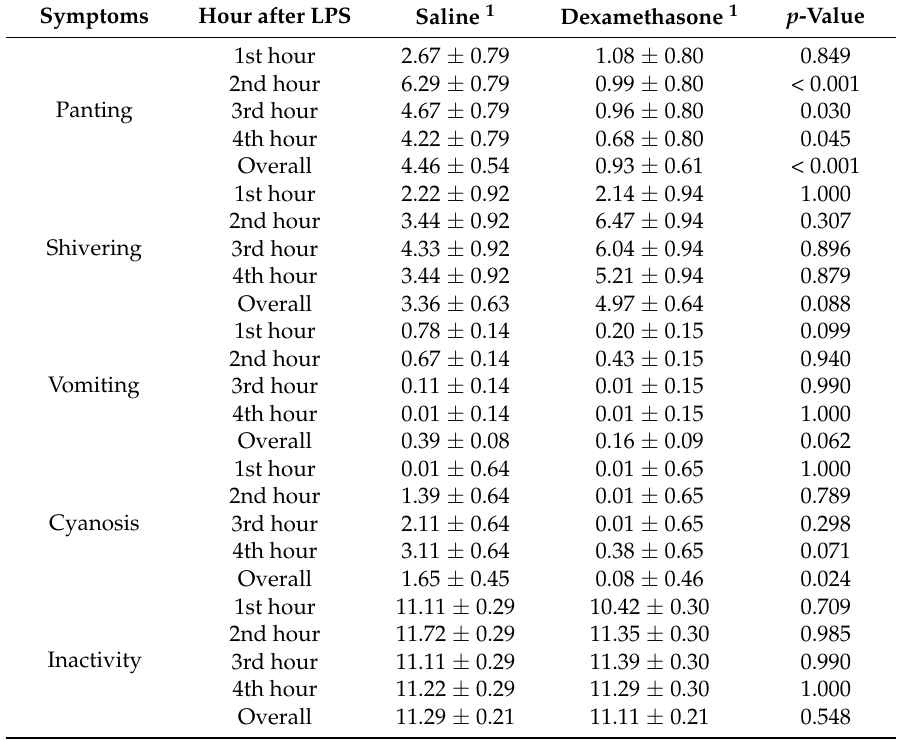
Table 1. The frequency of sickness symptoms in pigs following LPS